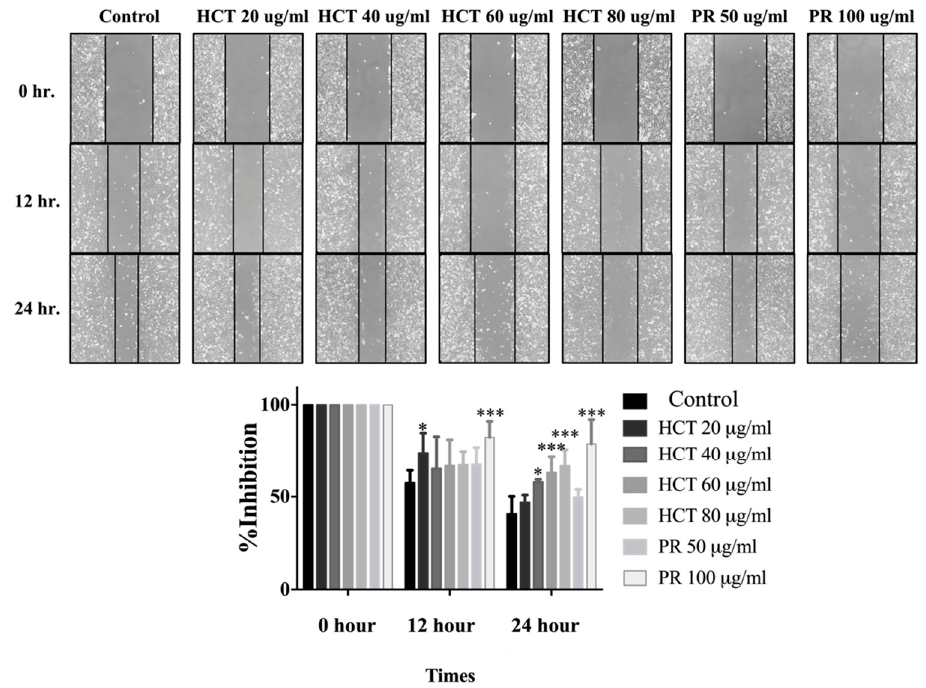
Figure 6. Effect of H. cordata and P. ribesioides extracts on breast cancer cell migration. Cells were treated with non-toxic doses for 24 h, and the wound healing assay was investigated. The percentage of effectiveness for inhibition on migration in bar graphs. Each value is presented as mean ± SD from three independent experiments. Data are the means ± SD. * p < 0.05 and *** p < 0.001 vs. control.